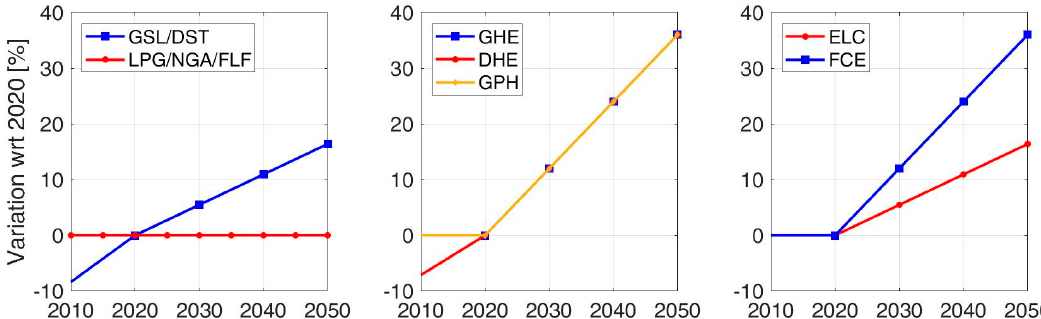
Figure 3. E ffi ciency variation with respect to 2020 applied to light-duty vehicles (LDVs), based on [11].